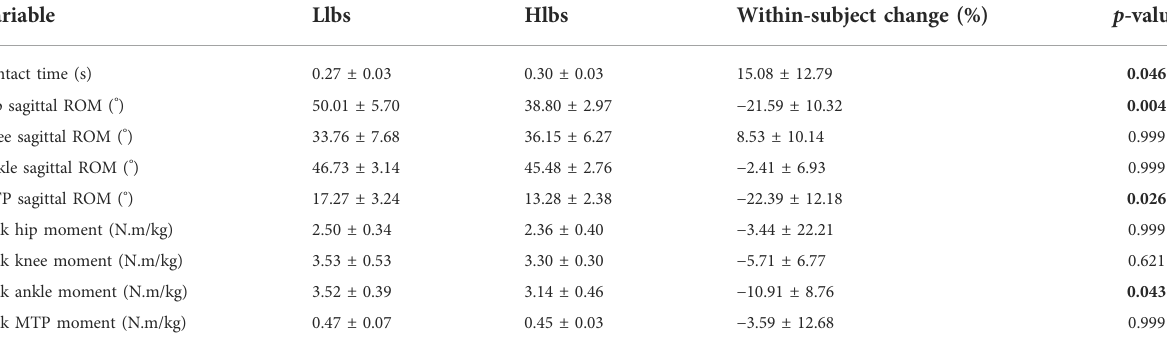
TABLE 2 Average contact time, ROM, and peak moment of lower limb joints during stance phase in the Llbs and the Hlbs shoes (mean ± SD).